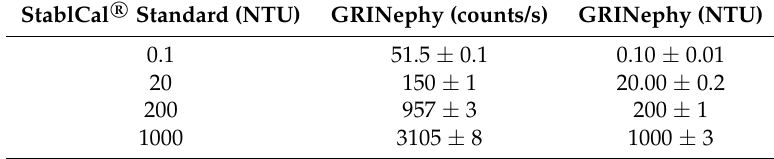
Table 1. Mean and standard deviation of measured StablCal R (cid:13) standards with our GRINephy in counts per second (middle column) and the converted NTU values (right